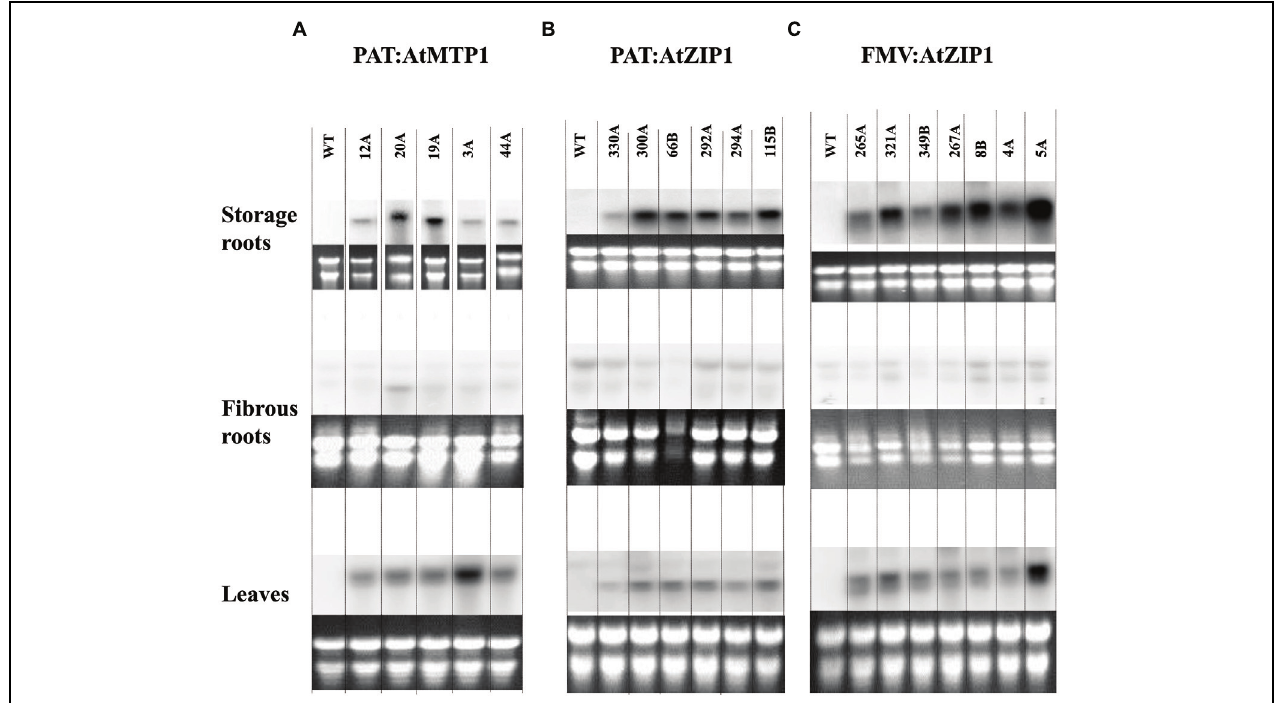
FIGURE 3 | Northern blot analysis for transgenic expression of AtMTP1 and AtZIP1 in storage parenchyma or tuberous roots, fibrous roots and leaves of 18 transgenic events. Transcript levels of the At MTP1 and At ZIP1 driven by patatin promoter (A,B)